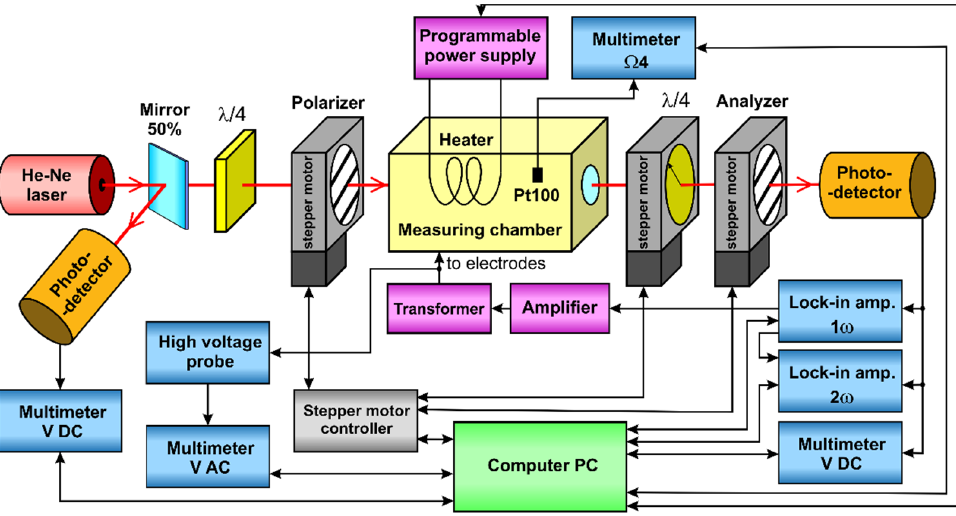
Figure 1. Block diagram of the measurement